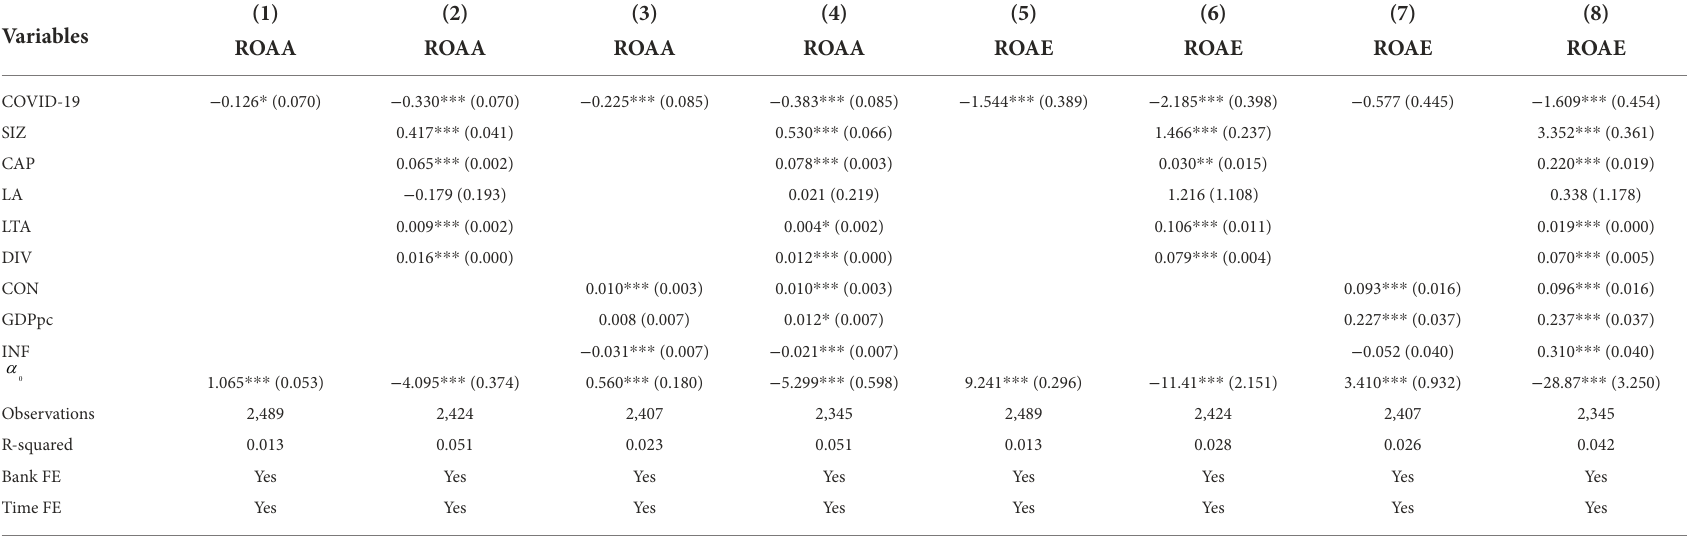
TABLE 3 COVID-19 impact on bank